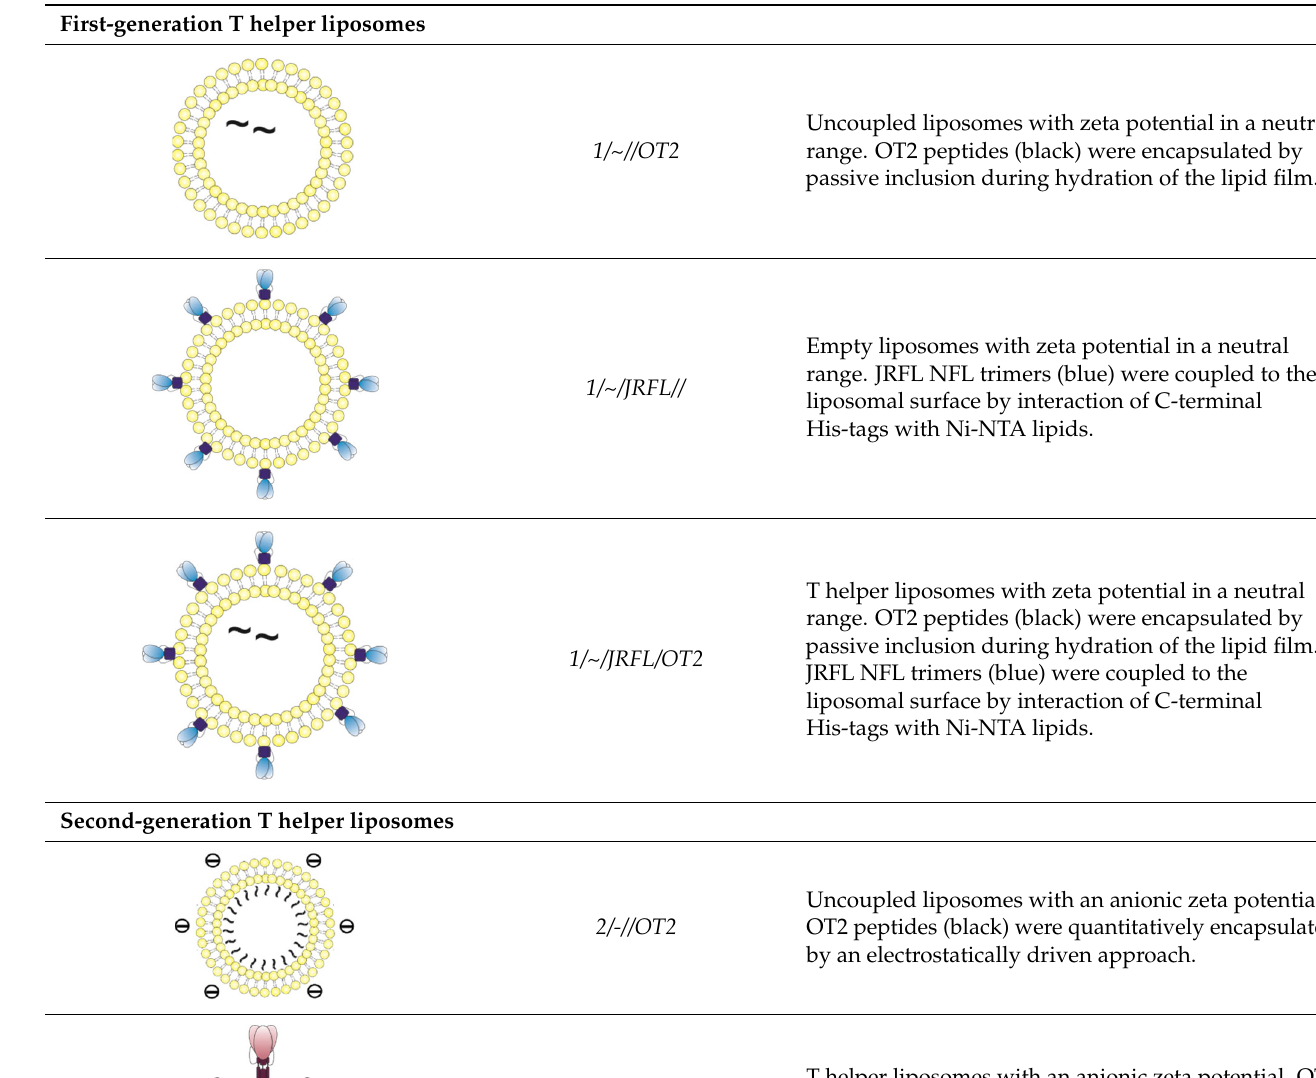
Table 1. Overview of different liposomal preparations used in this study. Schematic pictures of the liposomes and VLPs (left panel), particle codes (center) and production description (right). Liposomal codes: [Gen]/[Charge]/[Env]/[Peptide].